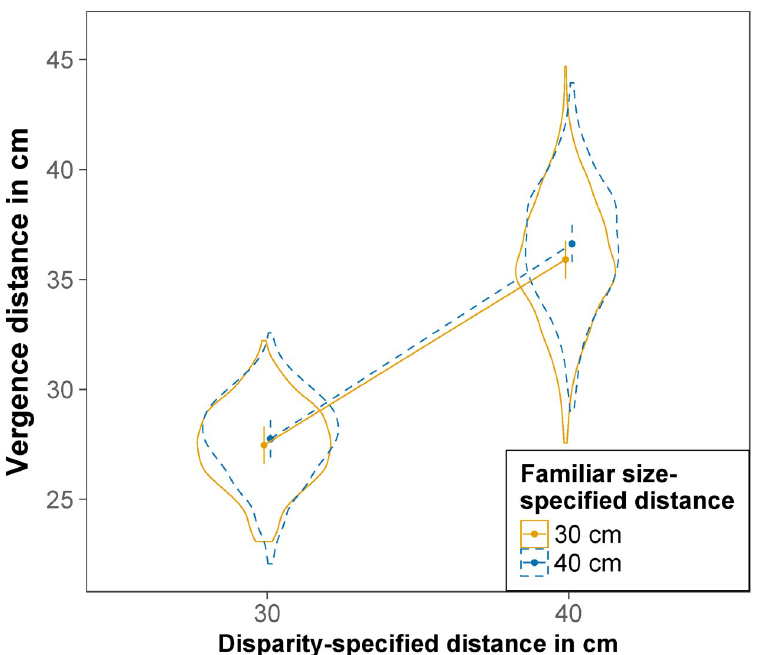
Fig 5. Vergence distance. Estimated marginal means of vergence distance for a binocular disparity-specified distance of 30 cm and 40 cm and a familiar size-specified distance of 30 cm (solid orange) and 40 cm (dashed blue). Error bars are model-based 95% confidence intervals indicating which values of the estimated means are likely and do not permit comparisons across repeated-measures factors [56]. Violin plots depict the distribution of the raw data.